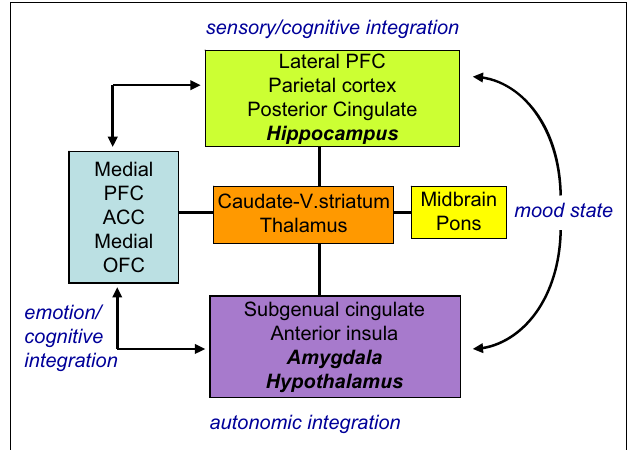
FIGURE 2 | Limbic-cortical dysregulation model. Interconnected regions are grouped into four ‘compartments’ relating to particular cognitive/ behavioural functions. Within compartments there may be a segregation between areas (shown in plain and italic text) showing an inverse relationship on different imaging paradigms. These interactions are dysfunctional in depression and modulated by successful treatment. Adapted from Mayberg (1997) and Mayberg et al.